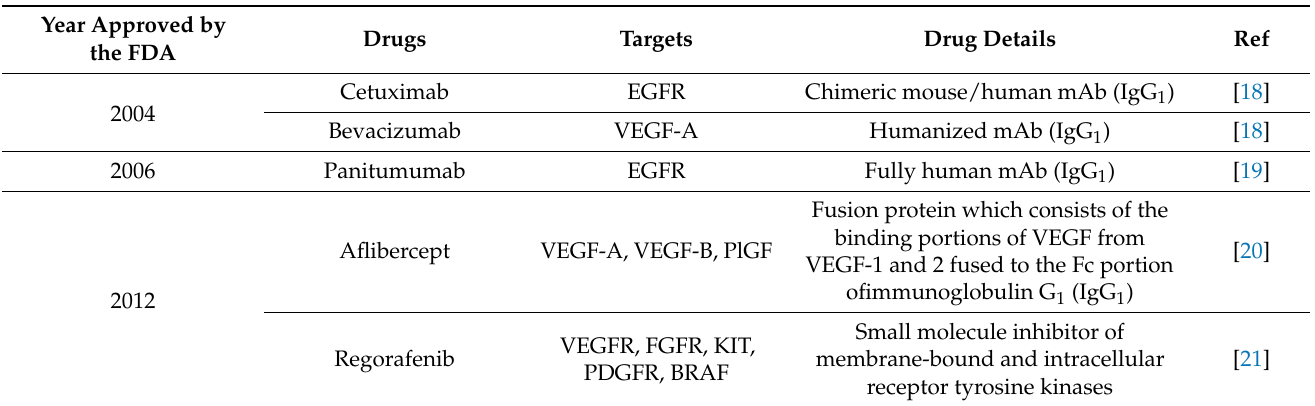
Table 1. FDA-approved targeted drugs for